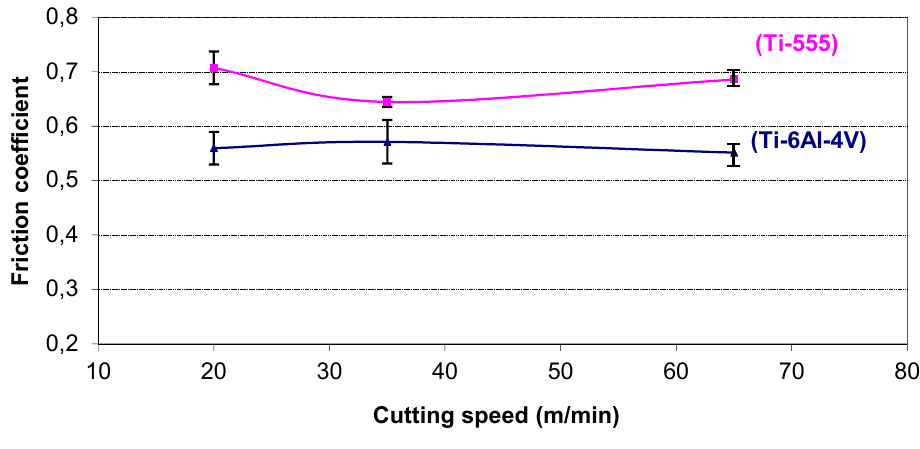
Figure 9. Evolution of the friction coefficient in the tool/chip interface. (Tool geometry “A”, rake angle